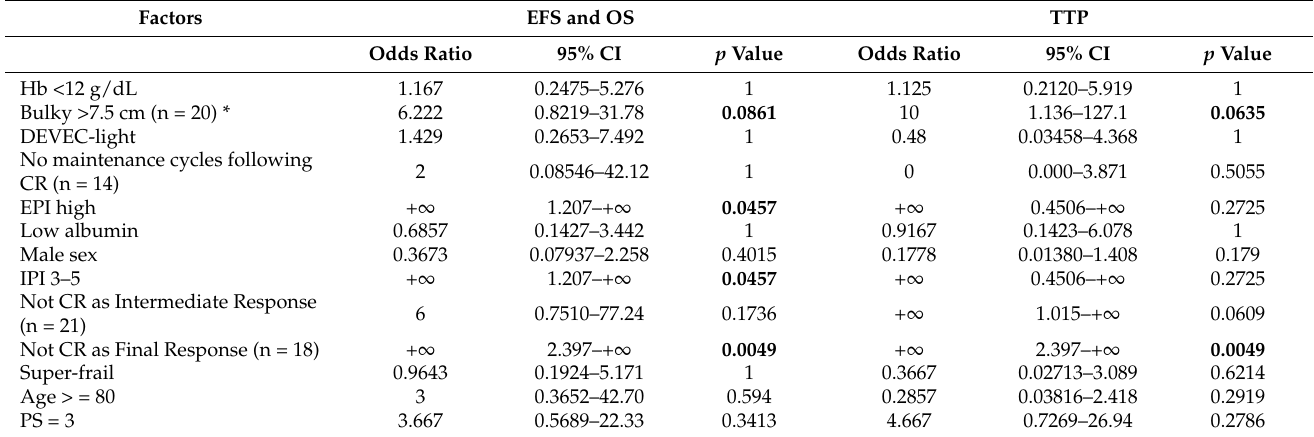
Table 3. Univariate analysis for OS, EFS and PFS of several risk factors.